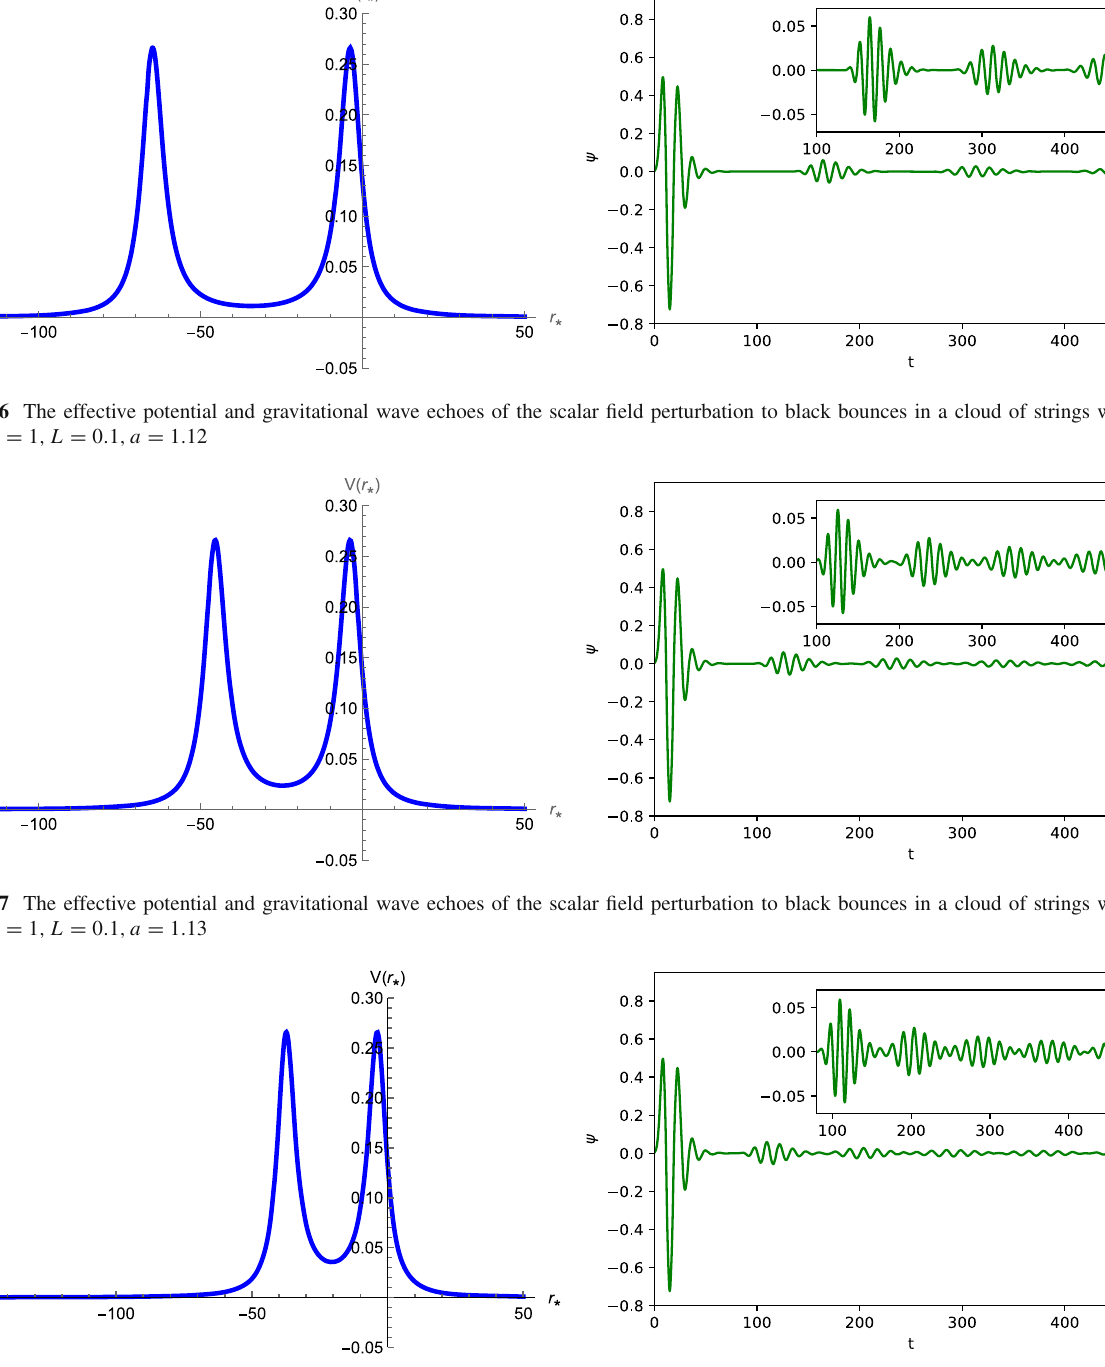
Fig. 8 The effective potential and gravitational wave echoes of the scalar field perturbation to black bounces in a cloud of strings with M = 0 . 5 , l = 1 , L = 0 . 1 , a = 1 .